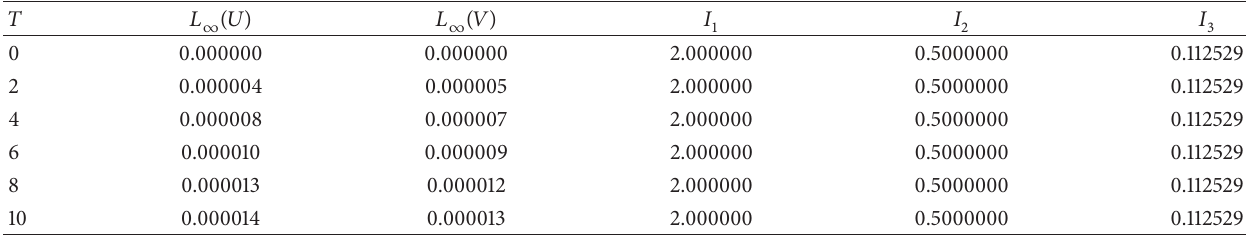
Table 2: Product approximation technique.